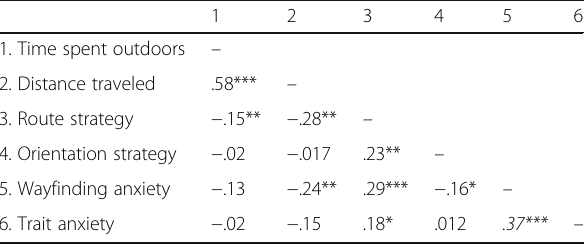
Table 1 Pearson correlation with time spent outdoors, distance traveled, route strategy, orientation strategy, wayfinding anxiety, and trait